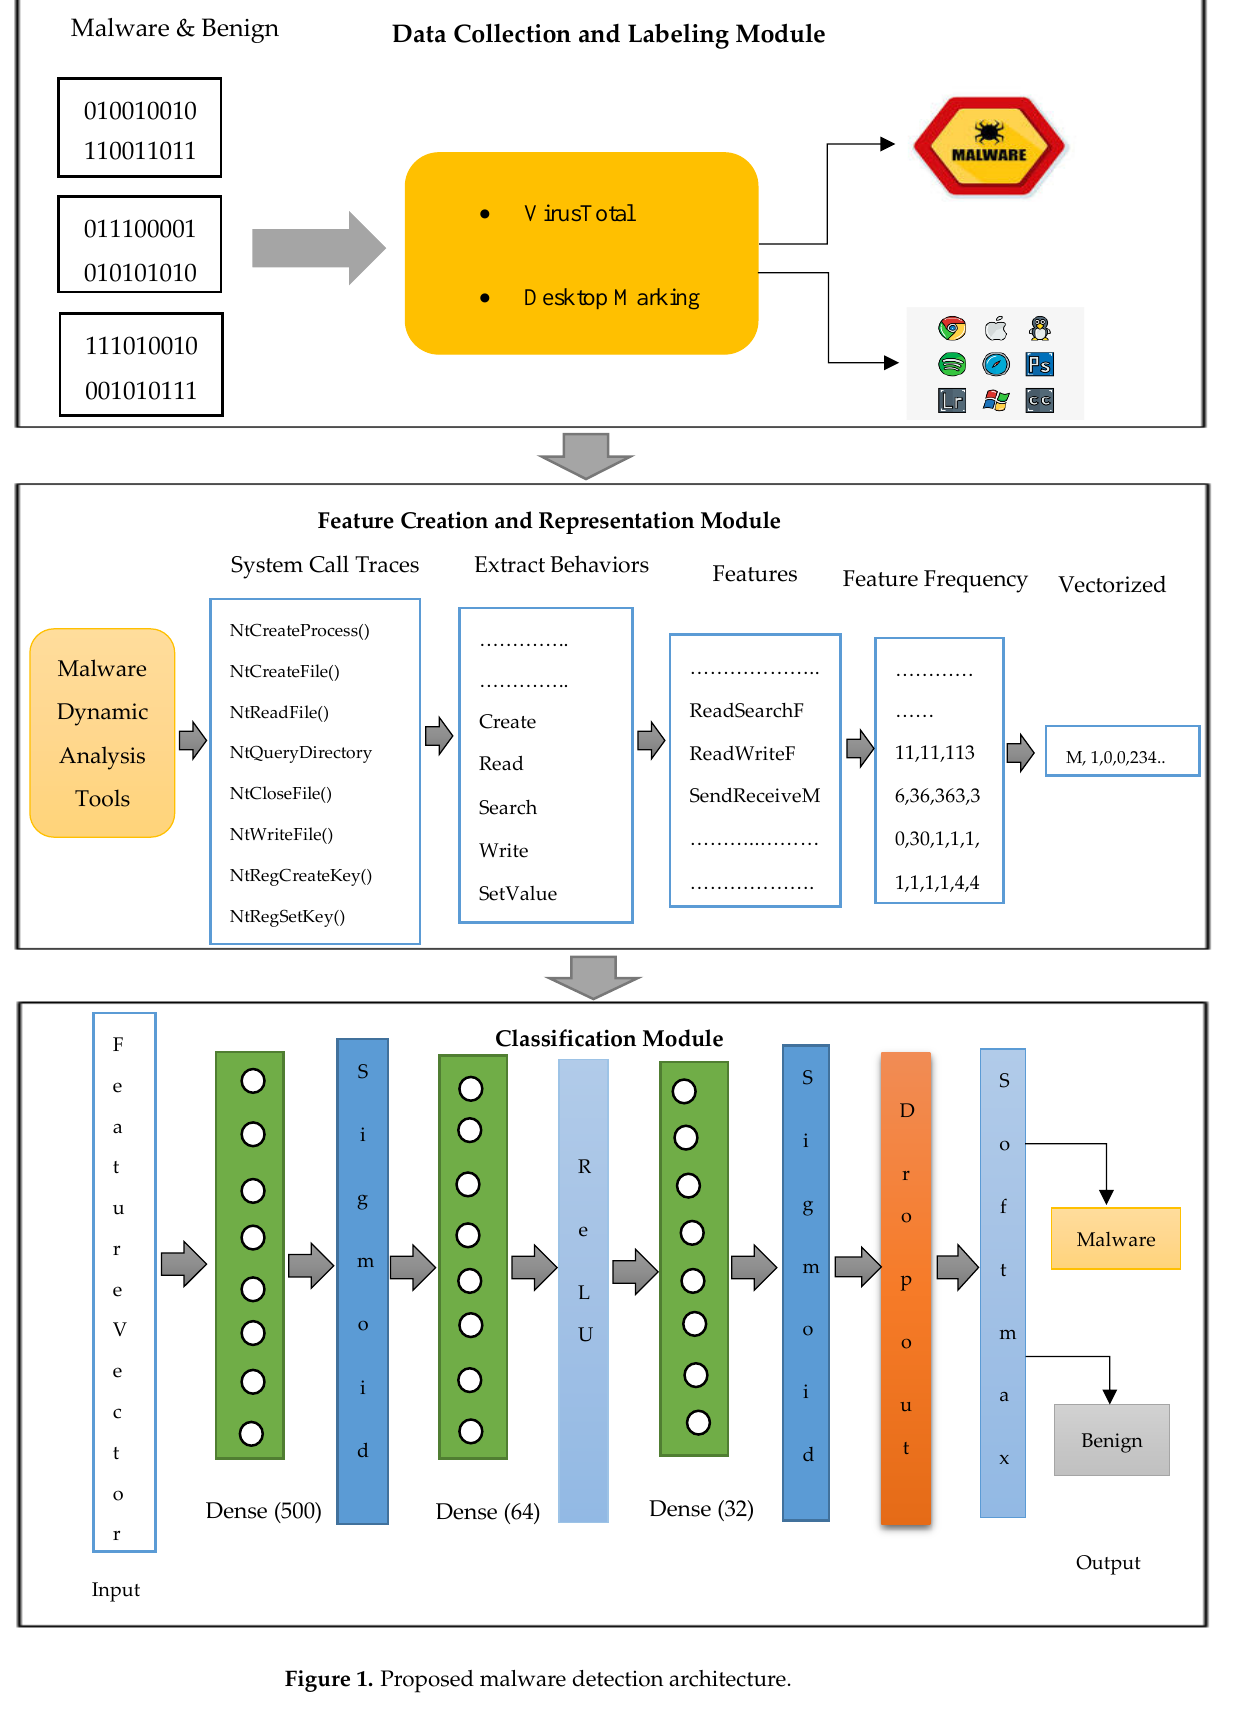
Figure 1. Proposed malware detection